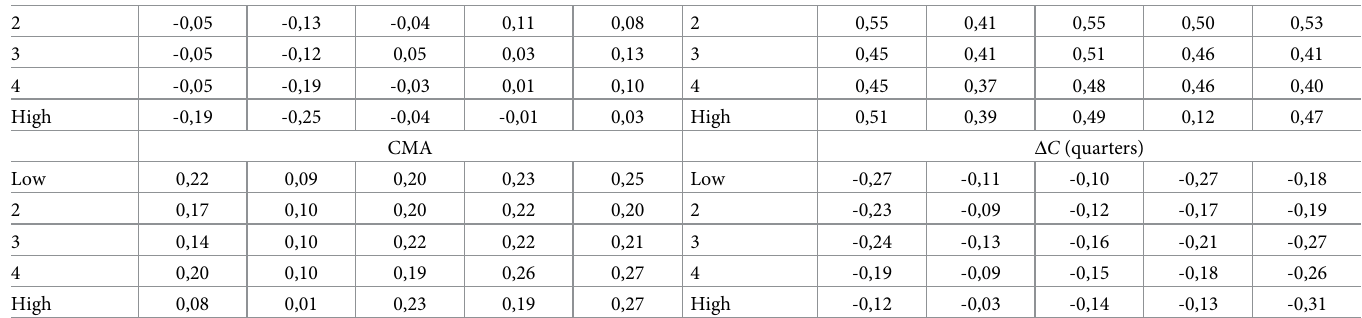
Table 3. Predictive power analysis for the CCI.